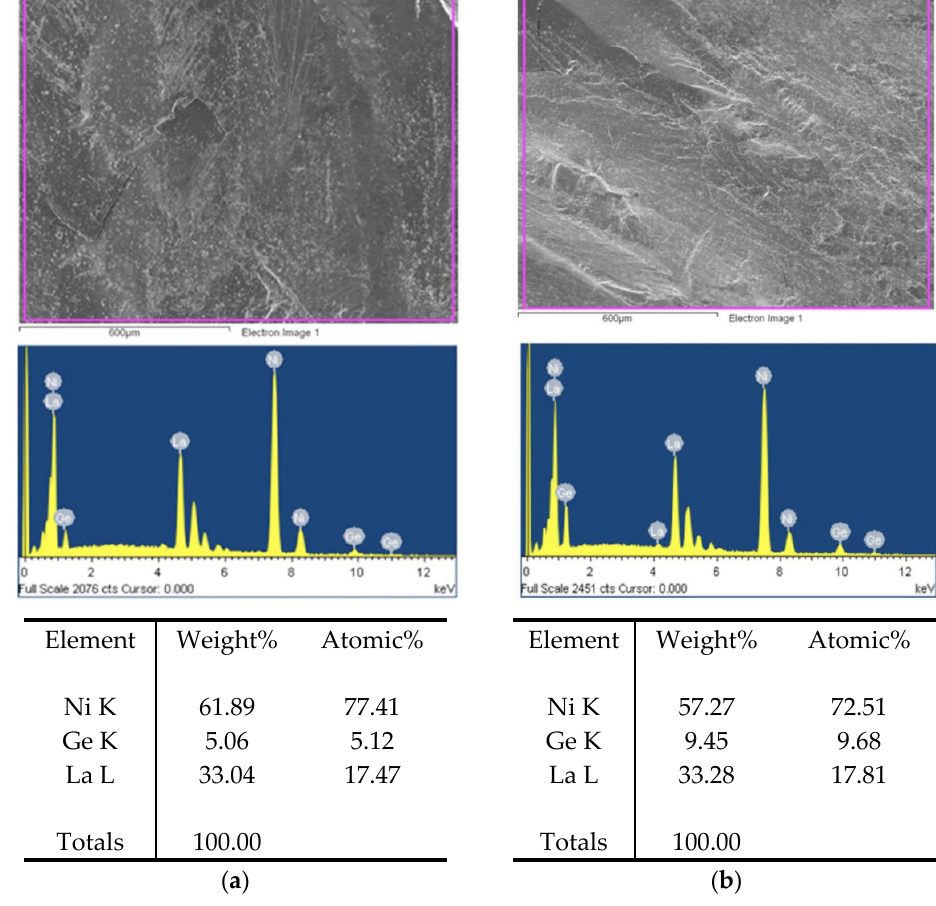
Figure 1. Results of EDS analysis: ( a ) LaNi 4.7 Ge 0.3 ( b ) LaNi 4.4 Ge 0.6 .